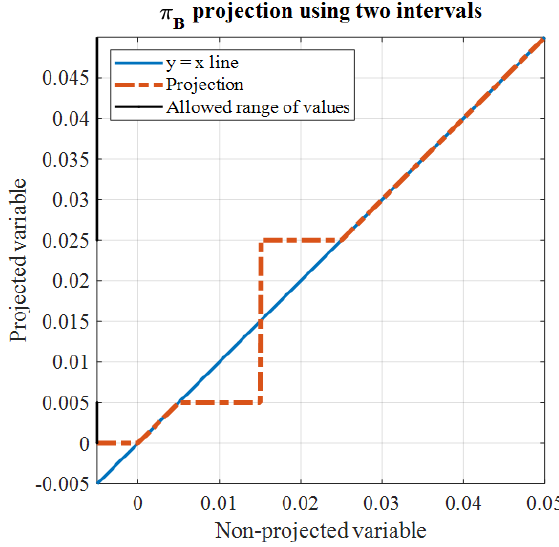
Figure A1. Projection using π B as per Eqs. (A3, A5–A6) using